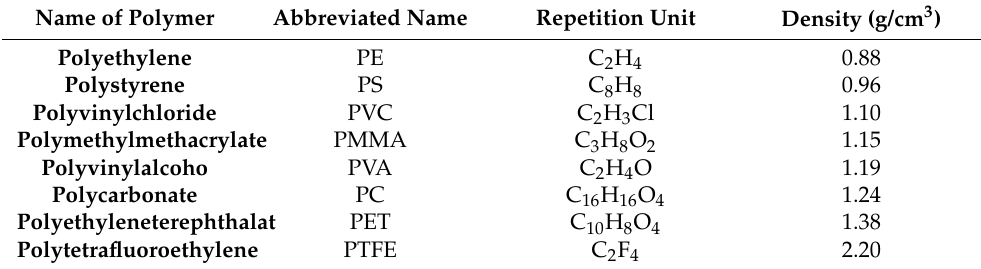
Table 8. Commonly used polymer properties.